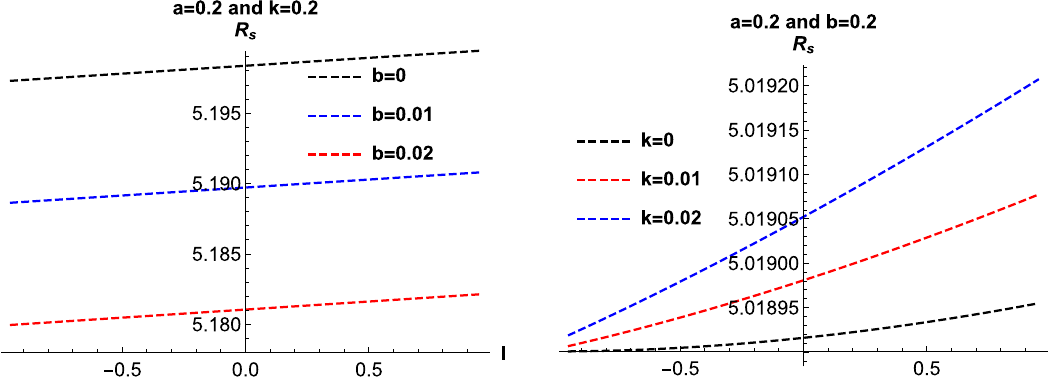
Fig. 12 The figure at the left side represent the variation of R s with l for different values of b with a = 0 . 2 and k = 0 . 2. The figure at the right side represents the variation of R s with l for different values of l with a = 0 . 2 and b = 0 .